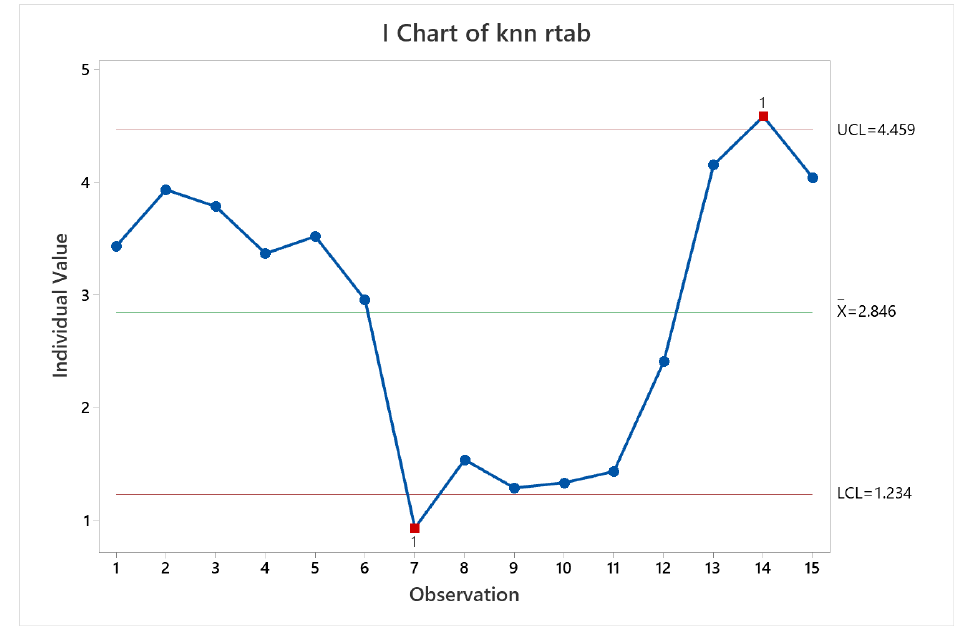
Figure 29. Map accuracy mean behavior for RTAB-Map.